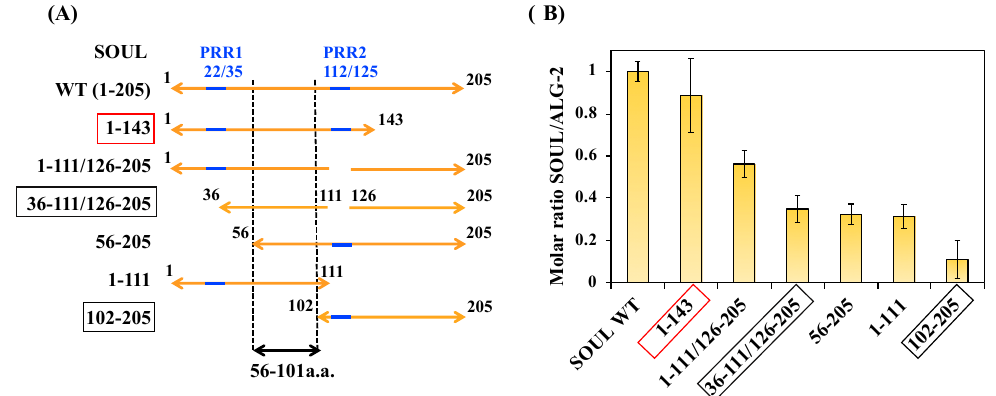
Figure 8. Interactions of SOUL mutants with ALG-2 in vitro. ( A ) PRR1 is 23-PSWKAPEDIDPQP-35 and PRR2 is 112-PSEQQPDPPRPSES-125 in blue. ( B ) GST-pulldown assays were performed using various purified mutants of His-SOUL (5 µ M) and purified GST-ALG-2 WT (5 µ M) proteins in the presence of Ca 2+ or EGTA. The intensity of the bands stained after SDS-PAGE was quantified by Multi Gauge version 2.1, and is represented as a relative value normalized to the value obtained with His-SOUL WT and GST-ALG-2 WT in the presence of 20 µ M Ca 2+ . Each value is the mean of at least three independent experiments ± SD.